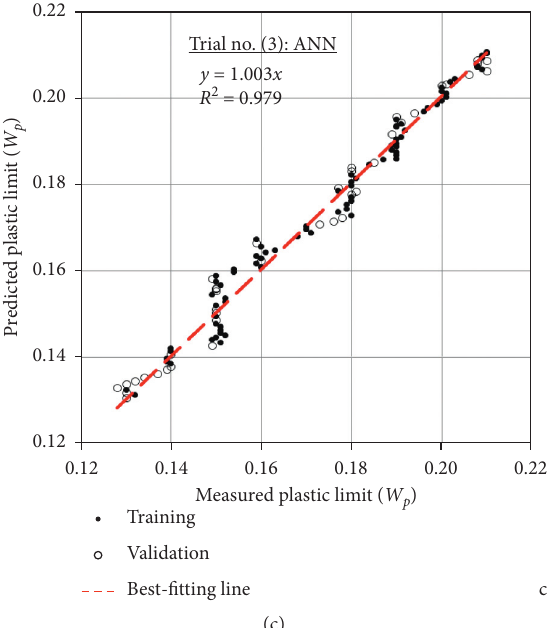
Figure 8: Relation between the predicted and calculated ( W